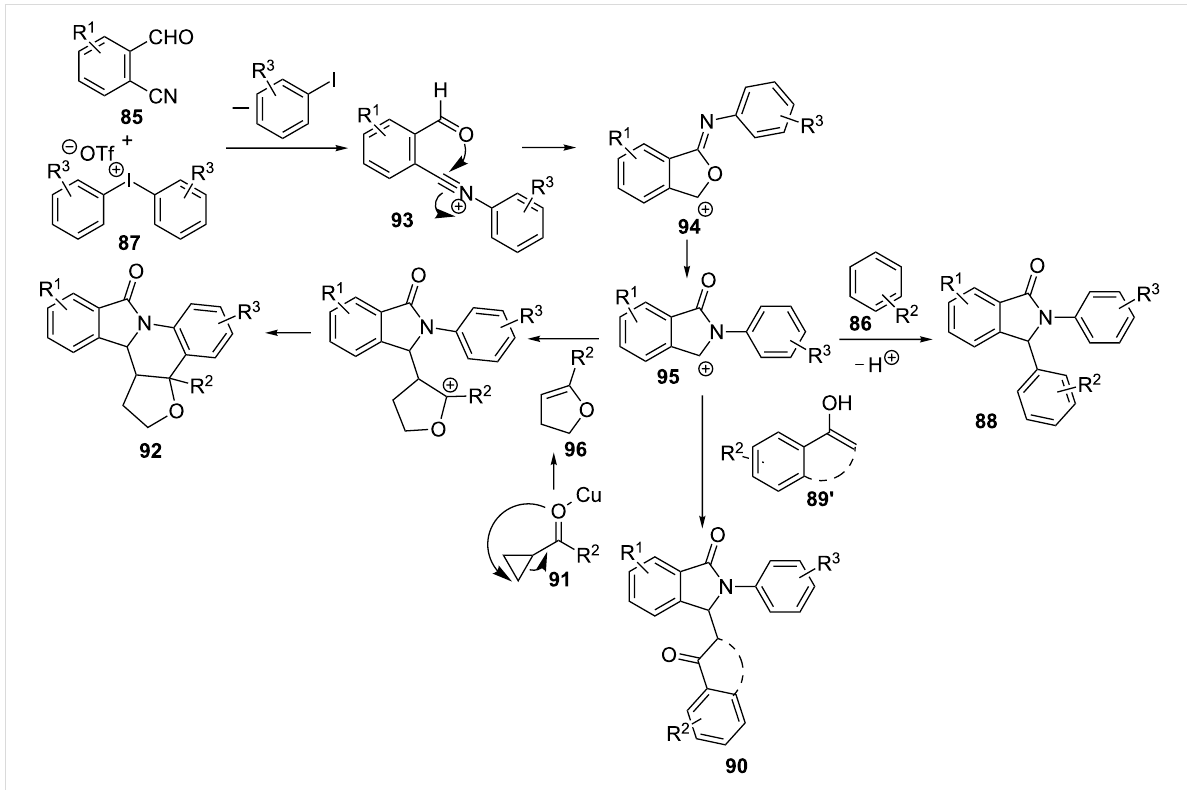
Scheme 27: Proposed mechanism for the formation of 2,3-diarylisoindolinones 88 , 89 and 92